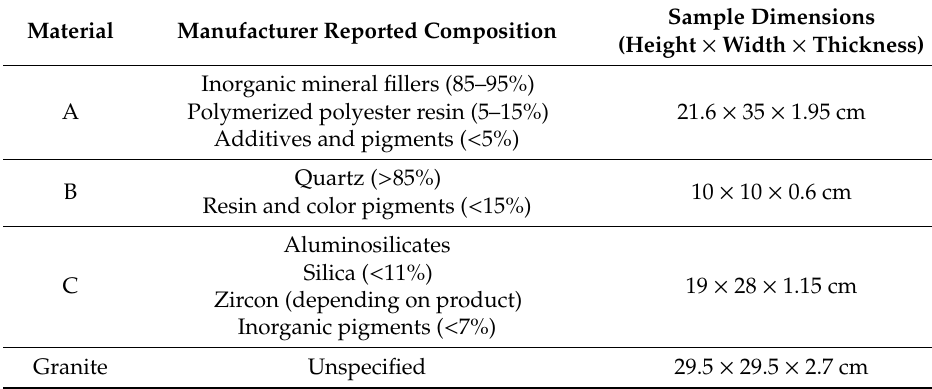
Table 1. Sample materials’ composition and